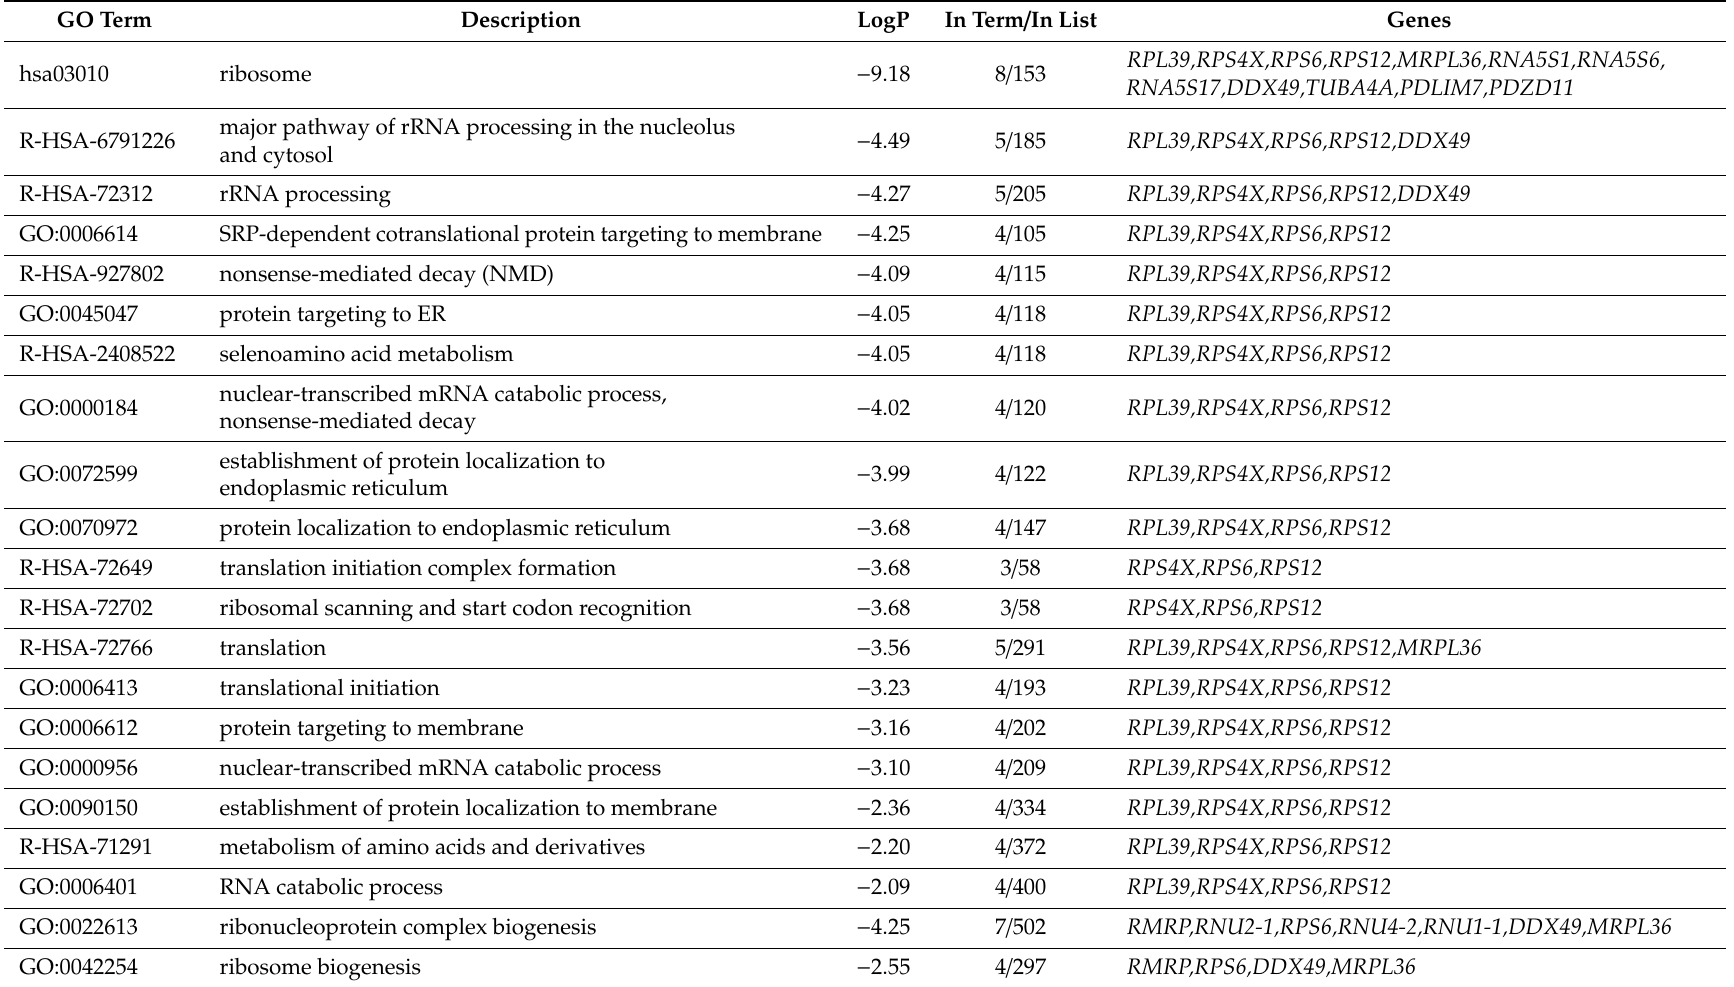
Table 6. Metascape functional annotation clusters for upregulated genes in embryos treated with FoEVs compared to